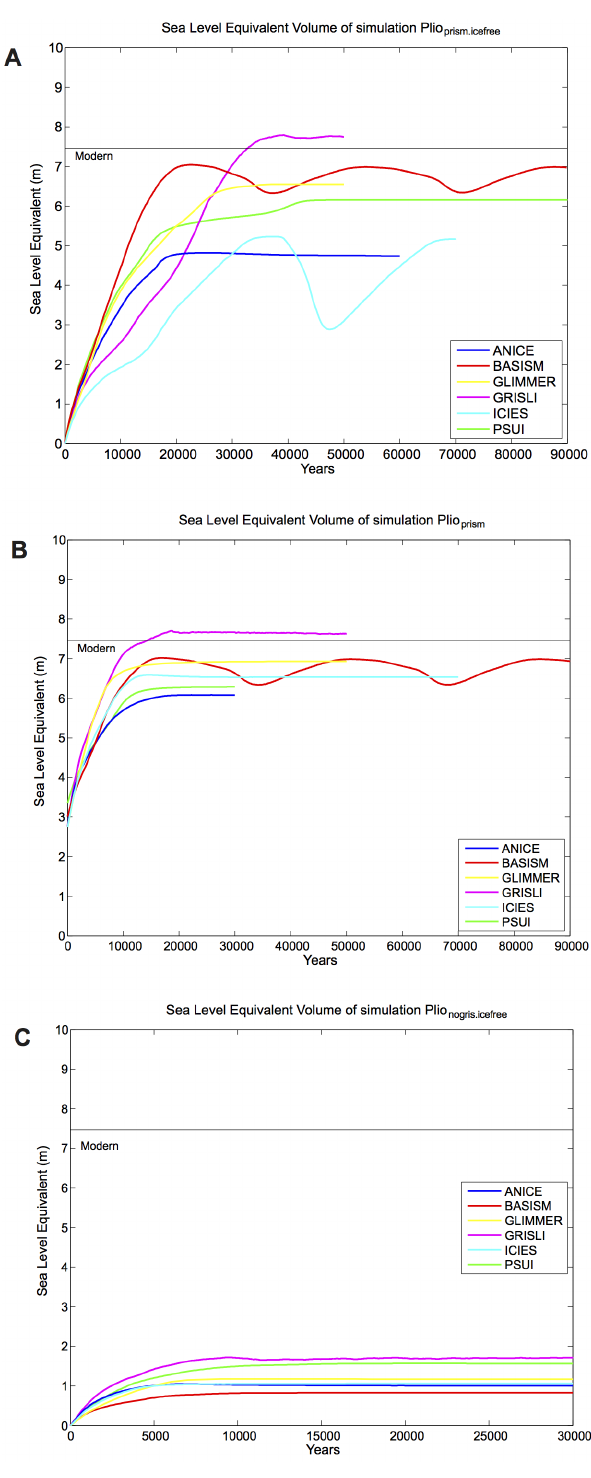
Figure 3. Evolution of ice sheet volumes expressed in sea level equivalent meters [m] for Pliocene scenarios (a) Plio prism . icefree , (b) Plio prism , and (c) Plio nogris . icefree for individual ice sheet mod- els. Observed present-day values from Bamber et al. (2001a) are indicated for reference. Note changes in integration lengths for sce- narios ( x axis).